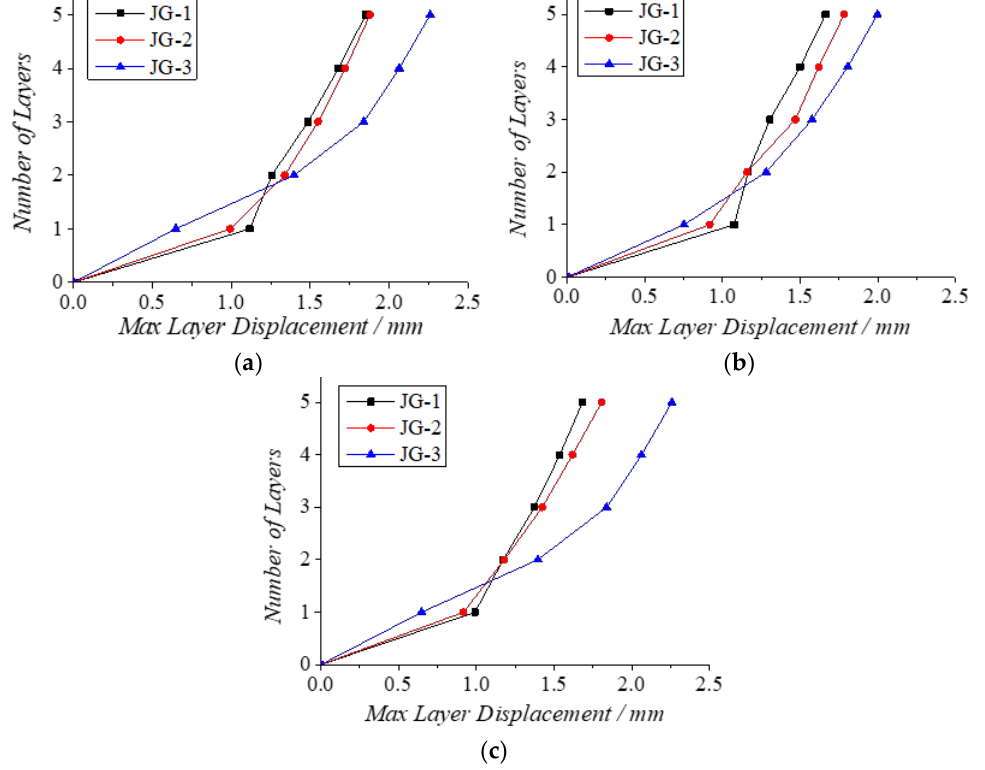
Figure 20. The maximum layer displacement. ( a ) Maximum layer displacement under the action of EL-Centro wave; ( b ) maximum layer displacement under the action of Taft wave; ( c ) maximum layer displacement under the action of TJYY wave.